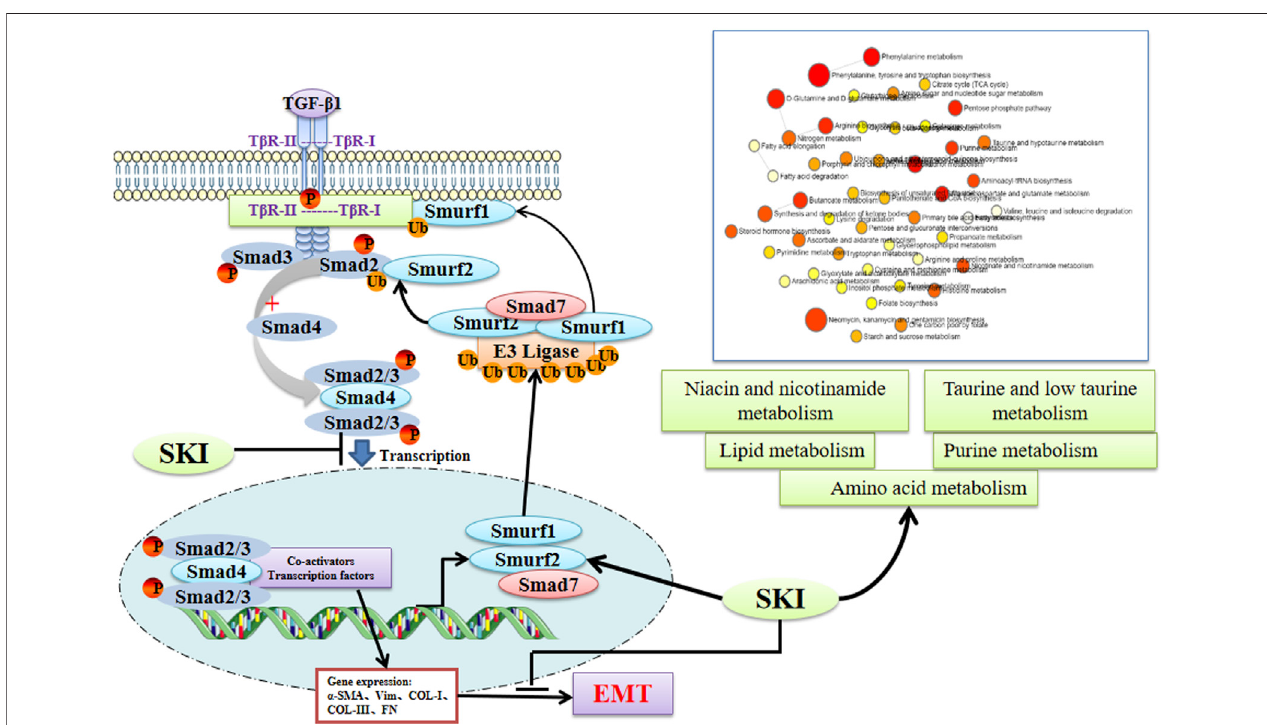
FIGURE15| TheunderlyingmechanismofLosartanontheTGF- β /Smadpathwayand themetabolomicsinUUOmice.SKIcanpromotetheexpressionofSmad7 and E3 ubiquitin ligases Smurf1 and Smurf2, promote the ubiquitination and degradation of the TGF- β /Smad signaling pathway, and improve the chances of lipid metabolism and amino acid metabolites, so as to achieve the prevention and treatment of renal fi brosis (created with BioRender.com).